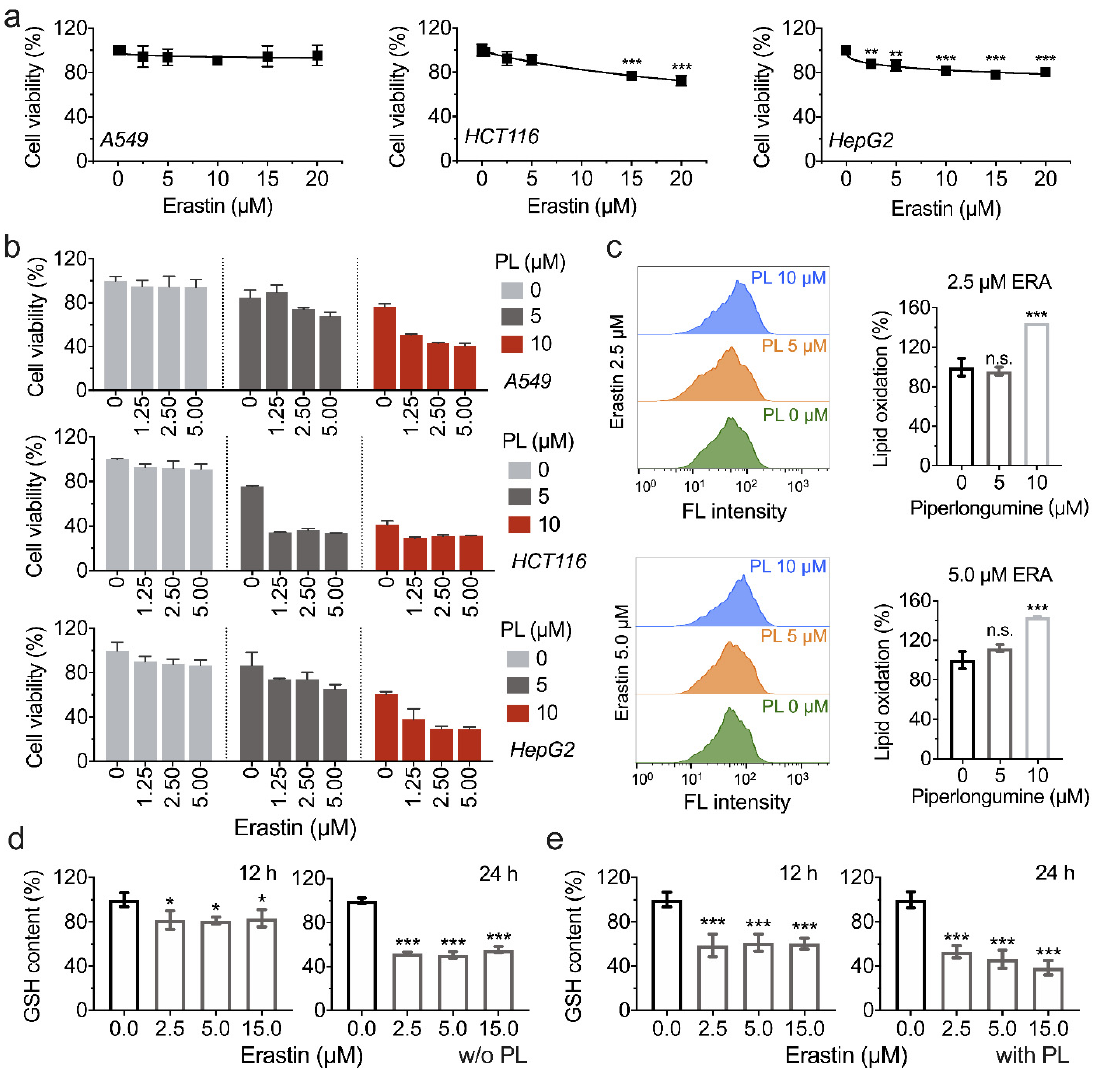
Figure 5. Piperlongumine may enhance erastin-induced cancer cell death. ( a ) Cytotoxicity of erastin on cancer cell lines. A549, HCT116, and HepG2 cells were treated with erastin in the range of 0 to 20 µM at various concentrations for 24 h and then the cell viabilities were measured by the CCK-8 assay. ( b ) Synergistic effect of erastin and piperlongumine. A549, HCT116, and HepG2 cells were incubated with both piperlongumine and erastin at the indicated concentrations for 24 h. Afterwards, the cell viability was measured by using the CCK-8 assay. ( c ) Piperlongumine forces erastin-induced ferroptosis. HCT116 cells were treated with piperlongumine and erastin as indicated, and the lipid oxidation was measured by BODIPY TM 581/591 C11 using flow cytometry. ( d , e ) GSH content in HCT116 cells upon erastin treatment with or without 5 µM piperlongumine.